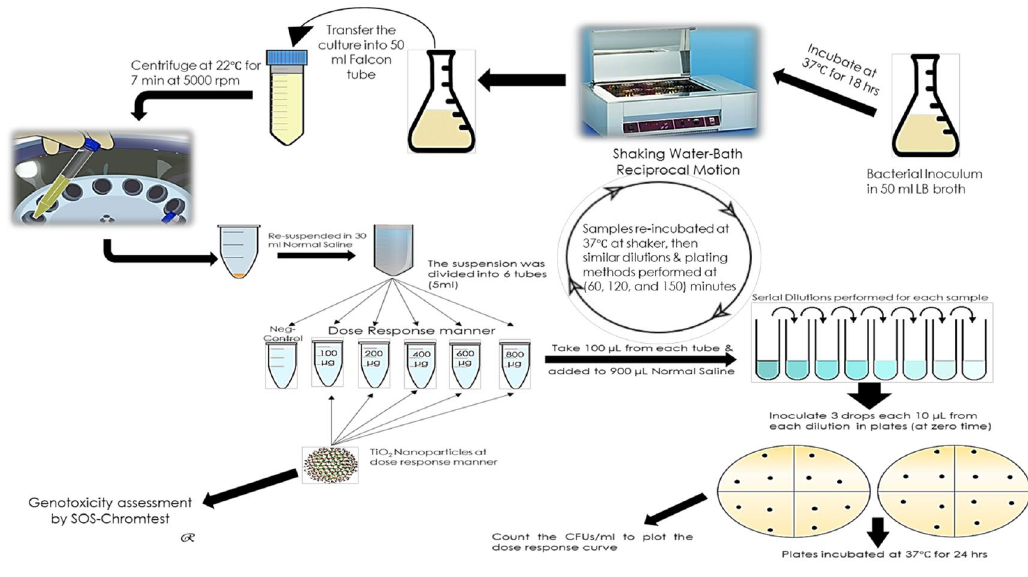
Fig. 2. Experimental Design of TiO2 NPs Antibacterial